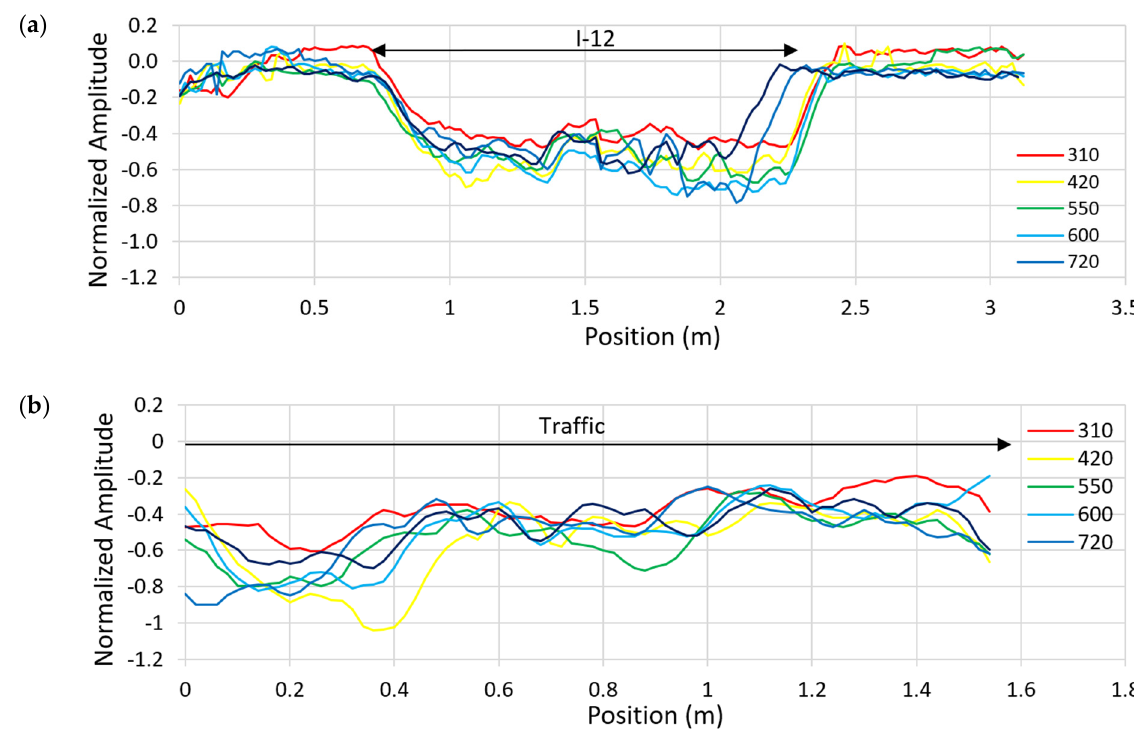
Figure 20. 5 GHz Norm. RW amplitudes on geotextile (I-12) in the ( a ) long. and ( b ) transv. direction vs. K loadings.